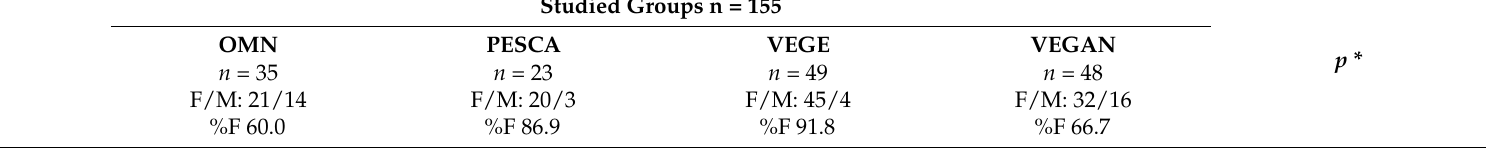
Table 1. Baseline laboratory